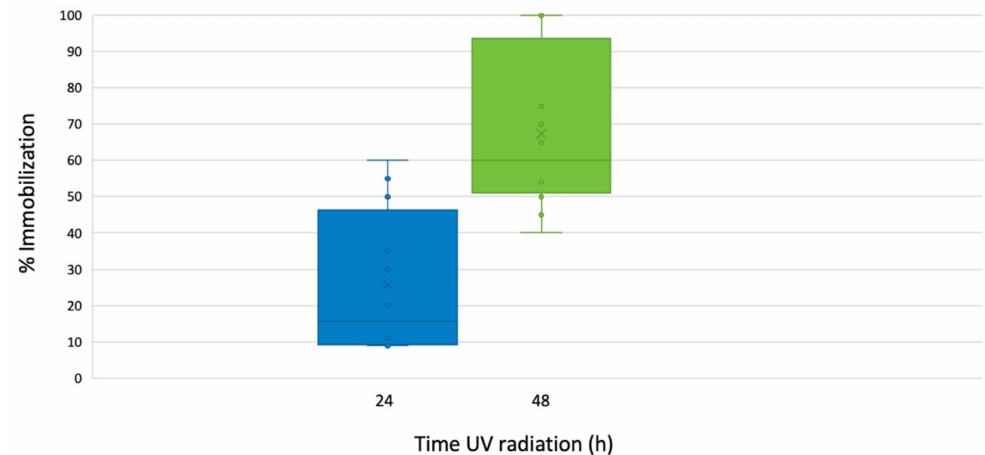
Figure 3. Percentage of immobilization for D. magna exposed to 24 and 48 h to SSR and nTiO 2 . The bars show the span of immobilization of the organism at 0.1, 1, 10, and 100 mg /L nTiO 2 .